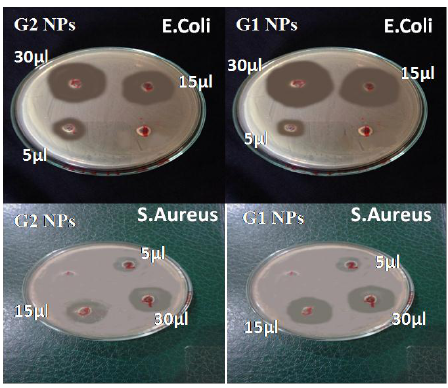
Figure 6. Well diffusion method of two sizes of gold nanoparticles (GNPs) against E. coli and S. aureus. Table 2. Calculation of zone of inhibition of (15 μL and 30 μL) of samples G1 and G2 of GNPs. Micro Organisms